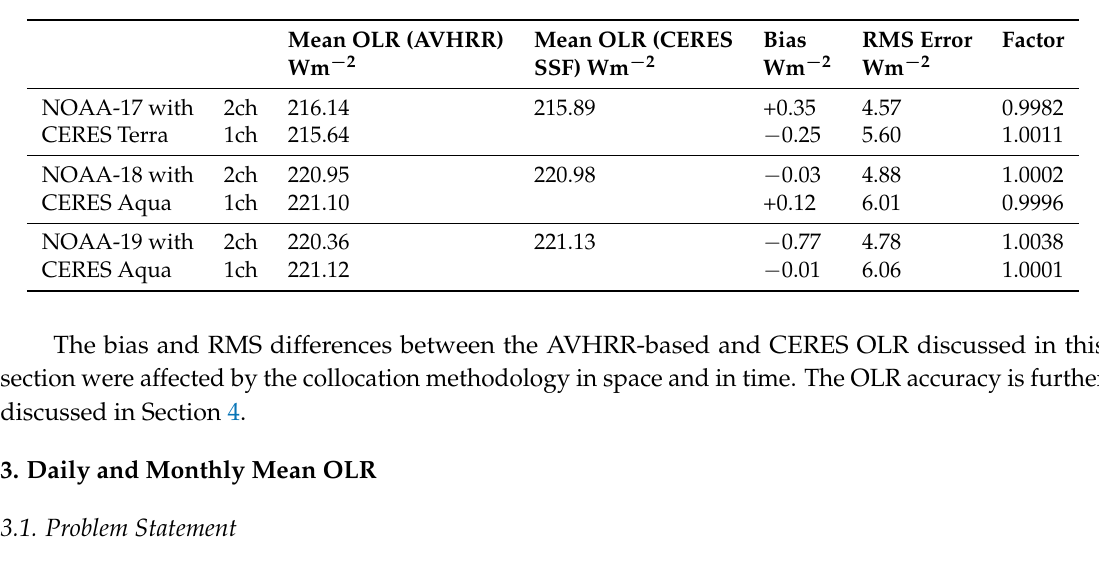
Table 3. Mean OLR, bias, and RMS error of the OLR estimation with Equation (1) (2 channels) and Equation (2) (1 channel) for the NOAA-17, -18, and -19. The last column gives the multiplicative factors to be applied to the estimated OLR to remove the